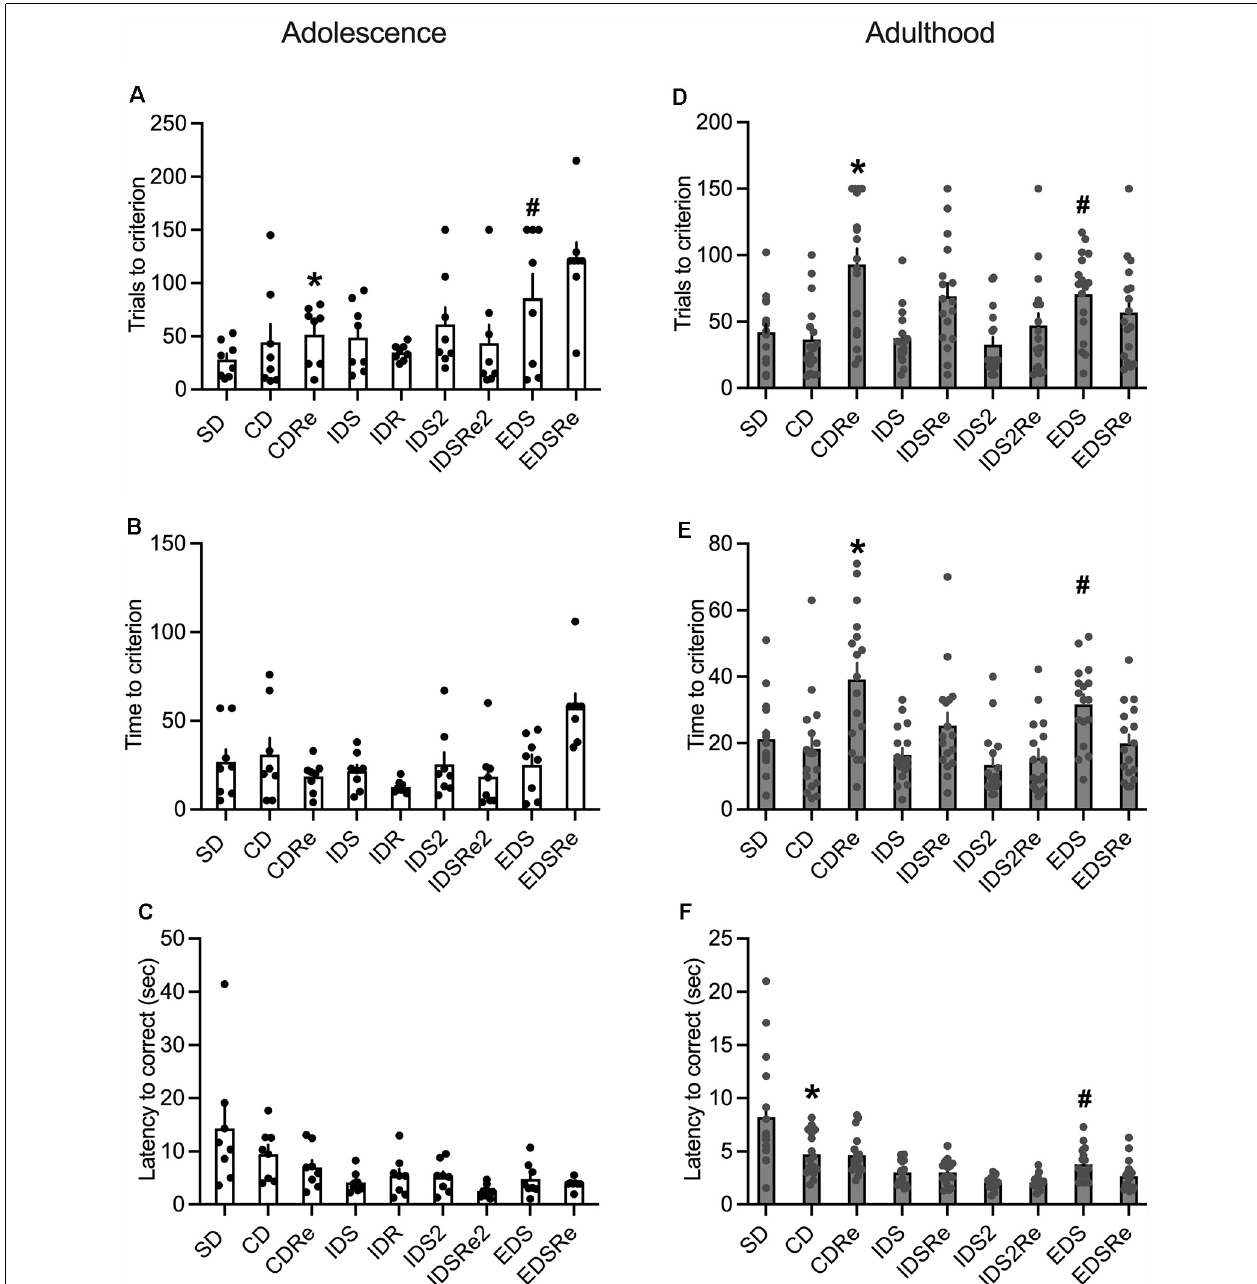
FIGURE 5 | (A) Number of trials (*CDRe: p < 0.005 vs. EDSRe. # EDS: p < 0.05 vs. SD, CD, IDR) and (B) time required by wild-type adolescent mice to reach the criterion in the different stages of ID/ED Operon task ( n = 8). (C) Latency to respond in each stage of the ID/ED Operon task in wild-type adolescent mice. (D) Number of trials (*CDRe: p < 0.0005 vs. SD, CD, IDS and IDS2, p < 0.005 vs. IDS2Re, p < 0.05 vs. EDSRe. # EDS: p < 0.05 vs. CD, IDS, IDS2) and (E) time required by wild-type adult mice to reach the criterion in the different stages of ID/ED Operon task (*CDRe: p < 0.00,005 vs. CD, p < 0.05 vs. IDSRe, p < 0.0005 vs. IDS2Re, p < 0.0005 vs. EDSRe. # EDS: p < 0.05 vs. CD, IDS, p < 0.0005 vs. IDS2). (F) Latency to respond in each stage of the ID/ED Operon task in wild-type adult mice (*CD p < 0.00,005 vs. IDS2. # EDS p < 0.0005 vs. IDS2). Values represent mean ± SEM. Abbreviations: CDRe, compound discrimination reversal; IDS2Re, intra-dimensional shift 2 reversal; SD, simple discrimination; EDSRe, extra-dimensional shift